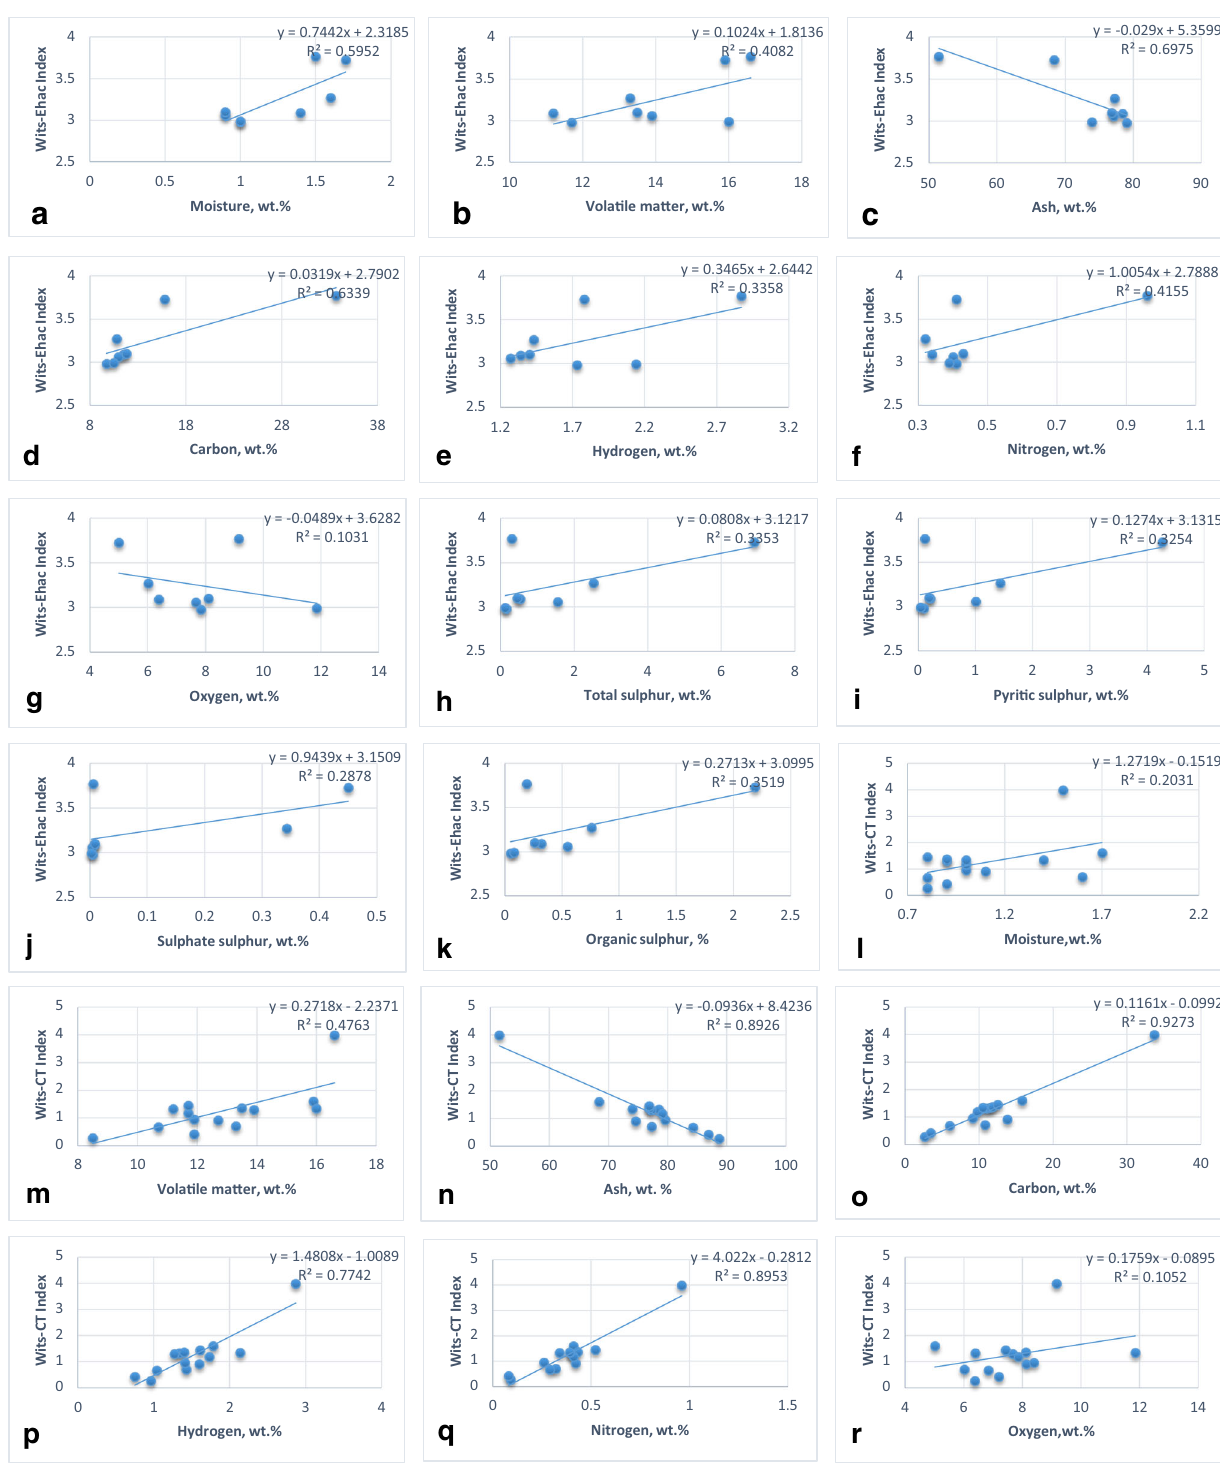
Fig. 6 Influence of proximate and ultimate analysis on sponatneous combustion of